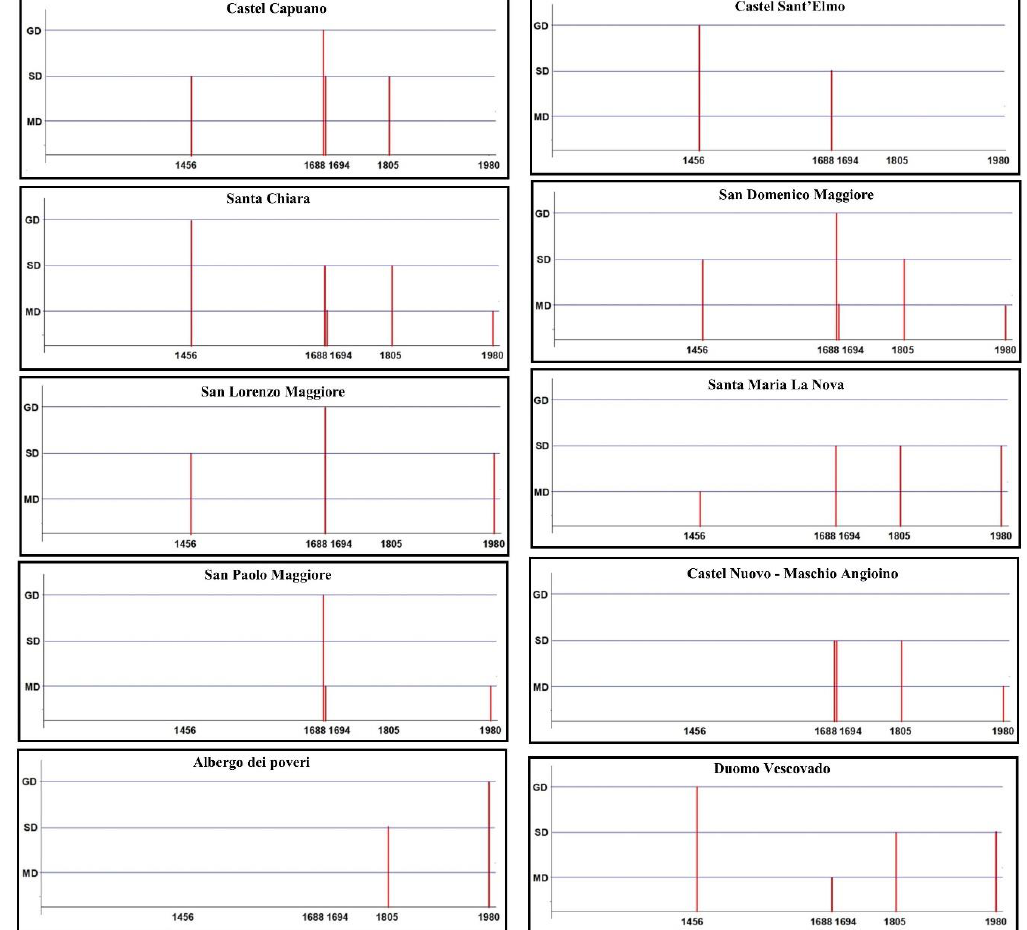
Figure 11. The graphs show the damage that the castles, historical buildings and churches suffered as a result of the historical earthquakes of the Southern